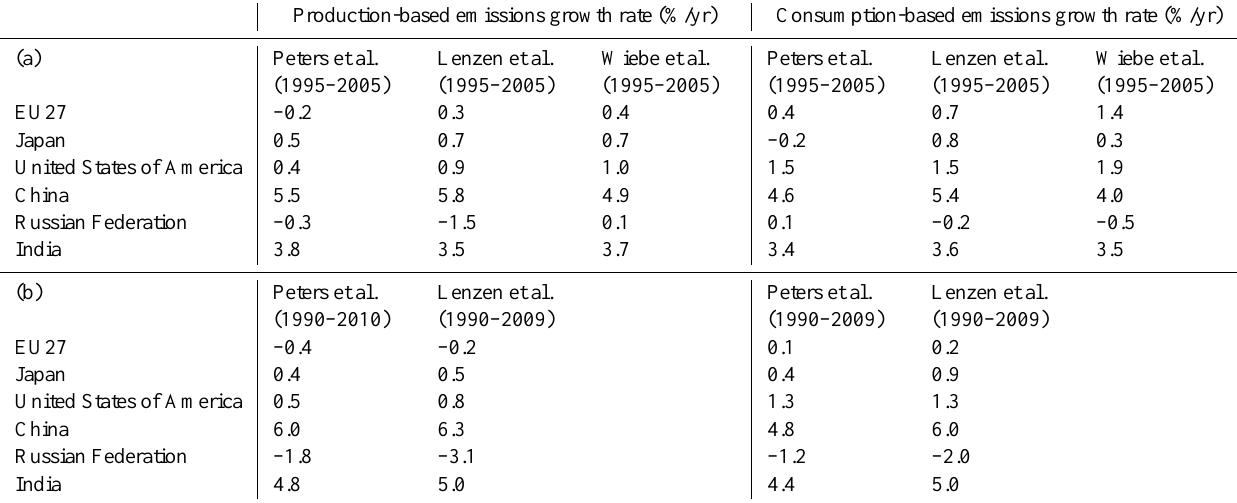
Table 1. A summary of the trends in three time-series studies of consumption-based emission estimates for key countries and regions (Peters et al., 2012; Wiebe et al., 2012; Lenzen et al., 2012). Comparisons are shown over the common time periods of each estimate (a) 1995–2005, (b) 1990–2009. Differences in the production growth rates are evident in the consumption growth rates. Production-based emissions growth rate